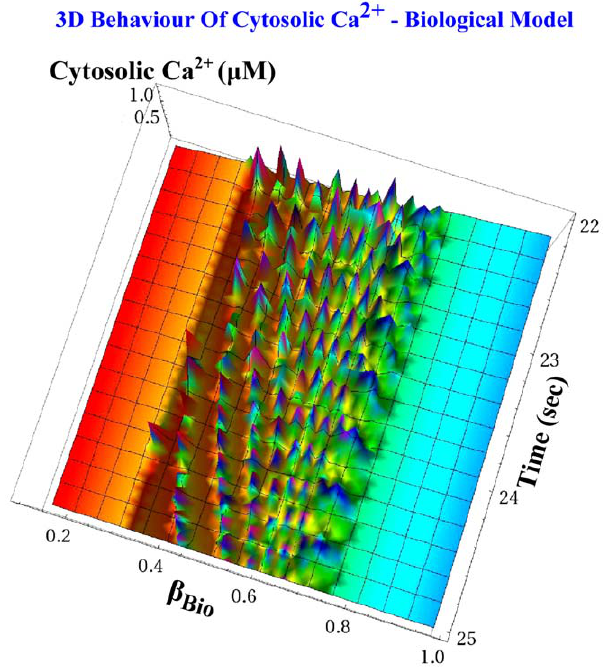
Figure 13. Three-dimensional representation of the cytosolic Ca 2 + oscillations based on the ideal biological model equations (1) for the m ~ n ~ 2, p ~ 4 case. Using parametric sweep analysis with respect to the b Bio parameter, the birthand the decayof the cytosolic Ca 2 z oscillations is presented. As expected, oscillations occurred only when 0 : 3 v b Bio v 0 : 7 .